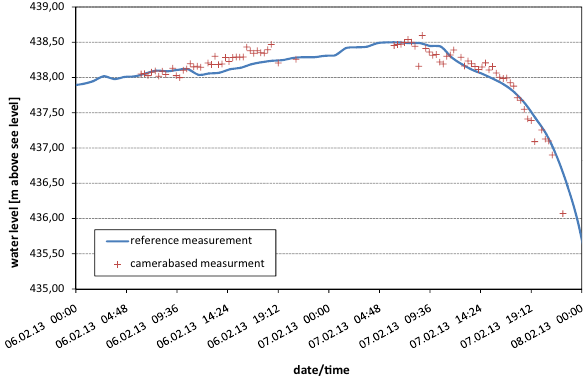
Figure 11. Photogrammetric water level measurements in comparison to reference